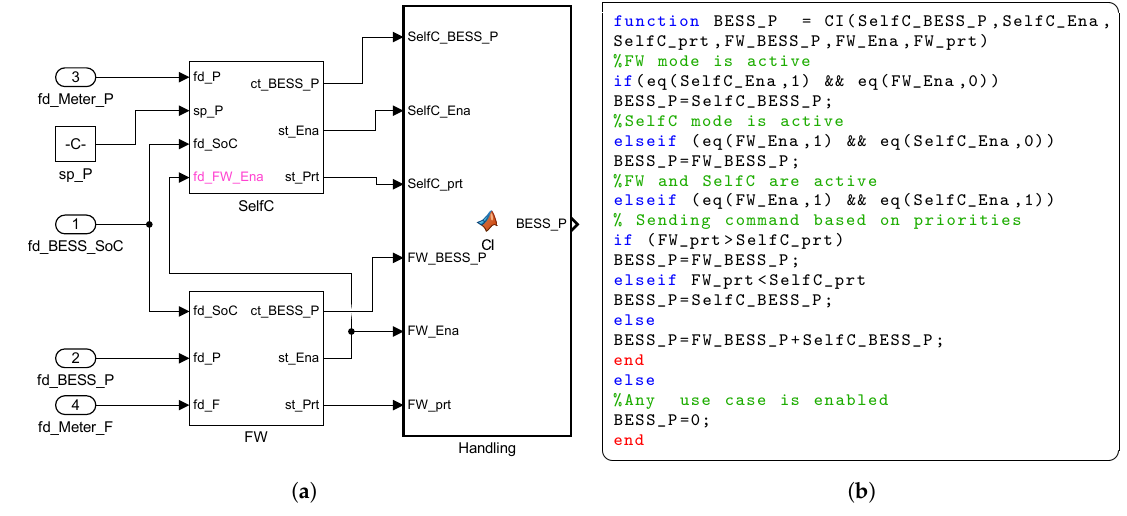
Figure 13. Software artifacts generated to be loaded within the power system emulator. ( a ) Simulink model generated; ( b ) CI function code generated.